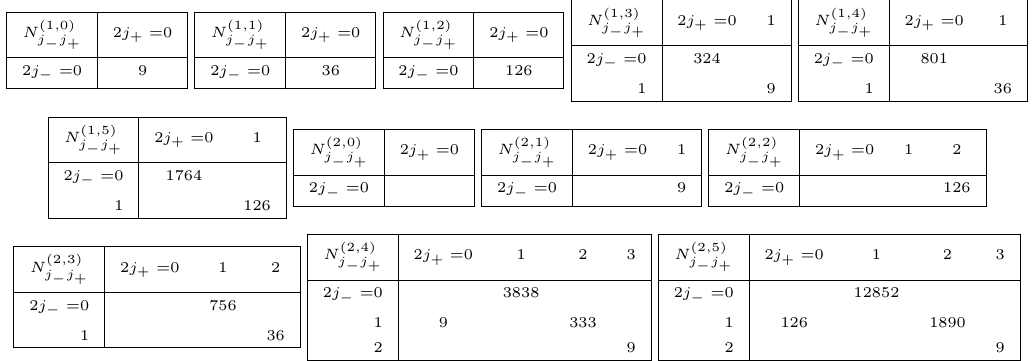
of M 3 , for base degree b (cid:20) 2 and (cid:12)ber degree d (cid:20) 5. j (cid:0) ;j +